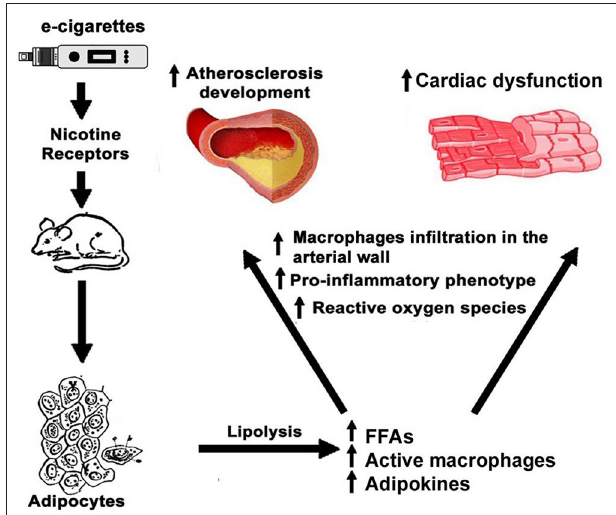
FIGURE 2 | Effects of e-cigarettes on adipocytes and cardiovascular system. In adipocyte tissue, nicotine in e-cigarettes produces the release of FFA and adipokines leading to the activation of macrophages and an inflammatory phenotype that detrimentally affects the cardiovascular system